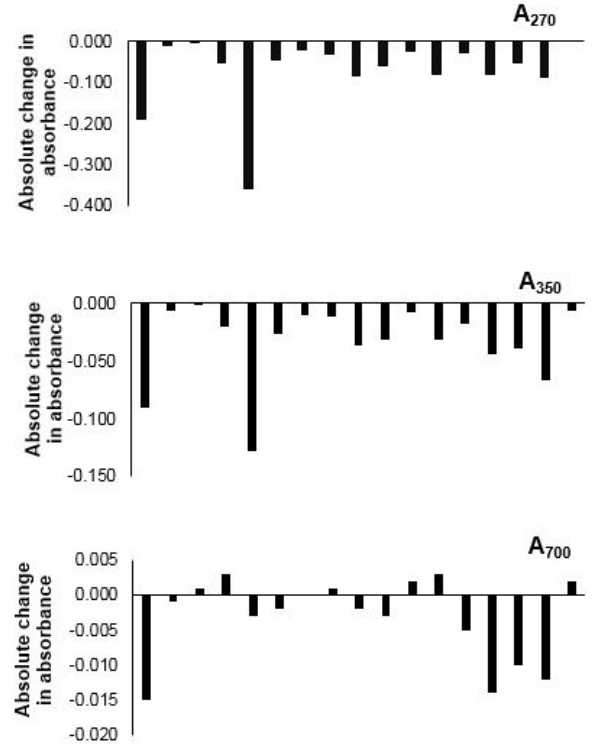
Figure 5. Experiment 2: changes in absolute absorbance values at 270 nm ( A 270 ), 350 nm ( A 350 ) and 700 nm ( A 700 ), following freeze/thaw. Positive values are increases. There is one set of 17 samples.